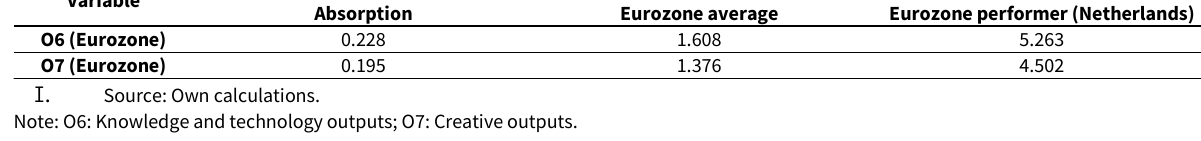
Table 11. Estimated impact of Portugal ’ s convergence on the Knowledge Absorption sub-pillar with the Eurozone average and top performer Estimated coefficient for Knowledge Variable